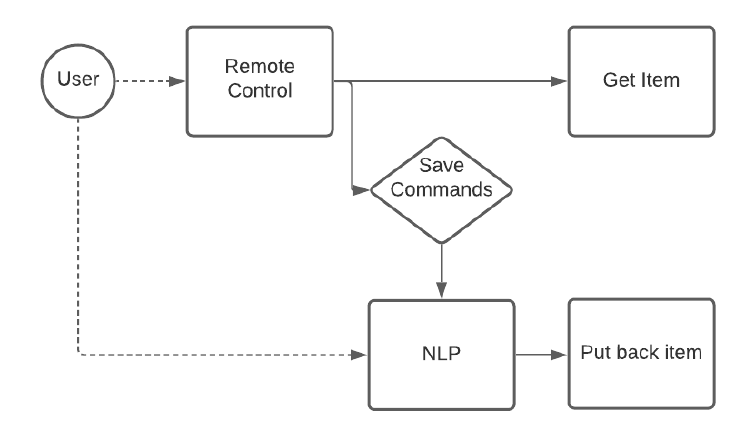
Figure 30. Flowchart of the integration of NLP into our